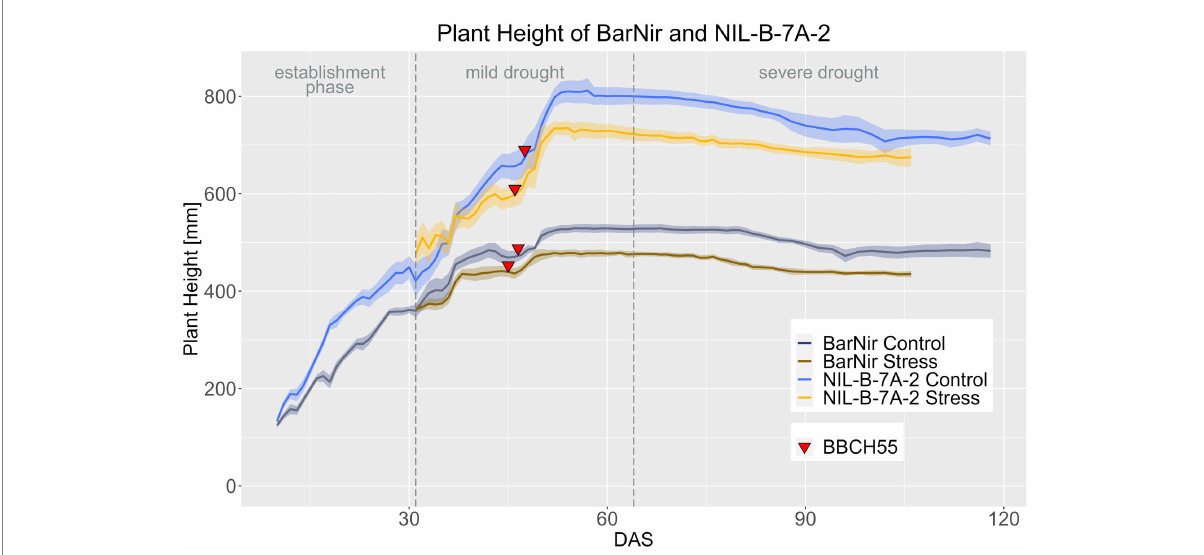
FIGURE 4 Plant height of BarNir and NIL-B-7A-2 based on the calculated BLUEs values. DAS, days after sowing; BBCH55, heading day. The last DAS for each genotype was chosen for the DAS where the last time 60% of the plants were imaged (as mature plants were taken off subsequently). The shadows describe the confidence interval; as long as the shadows of the individual lines do not overlap, the significance level of a = 0.05 is not reached and therefore a significant difference exists.